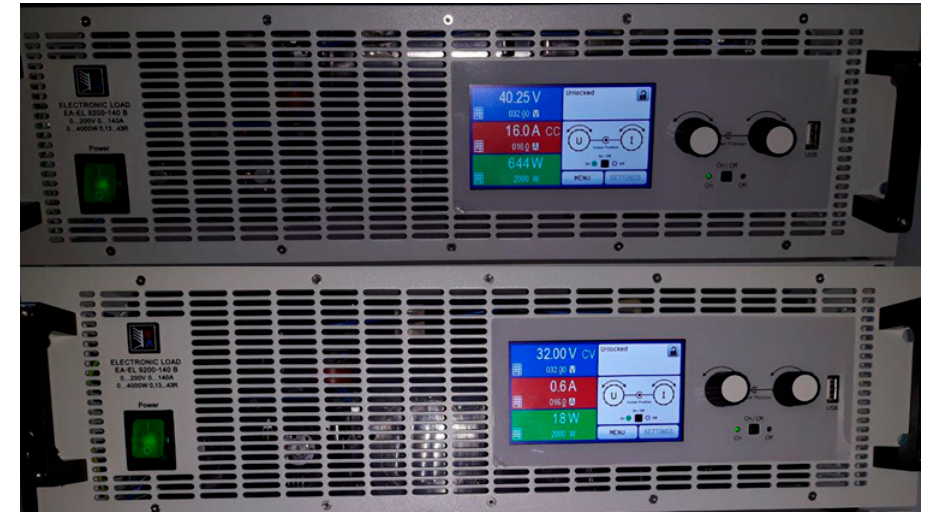
Figure 12. EA electronic power supply and load.